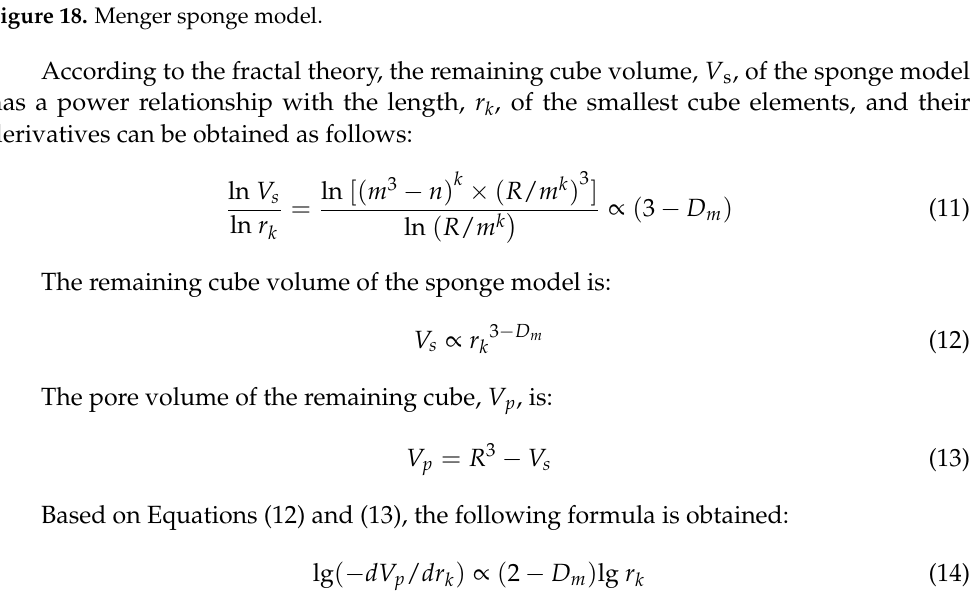
Figure 19. Total porosity and fractal dimension.